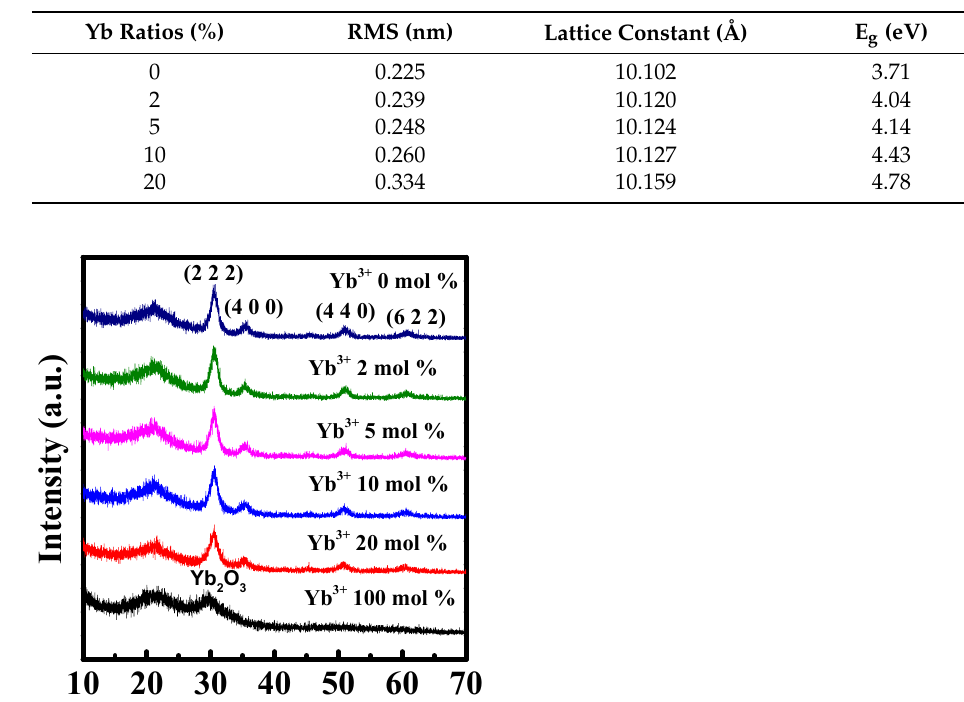
Table 1. RMS roughness, lattice constant, and optical bandgap of In-Yb-O thin films with different Yb ratios.